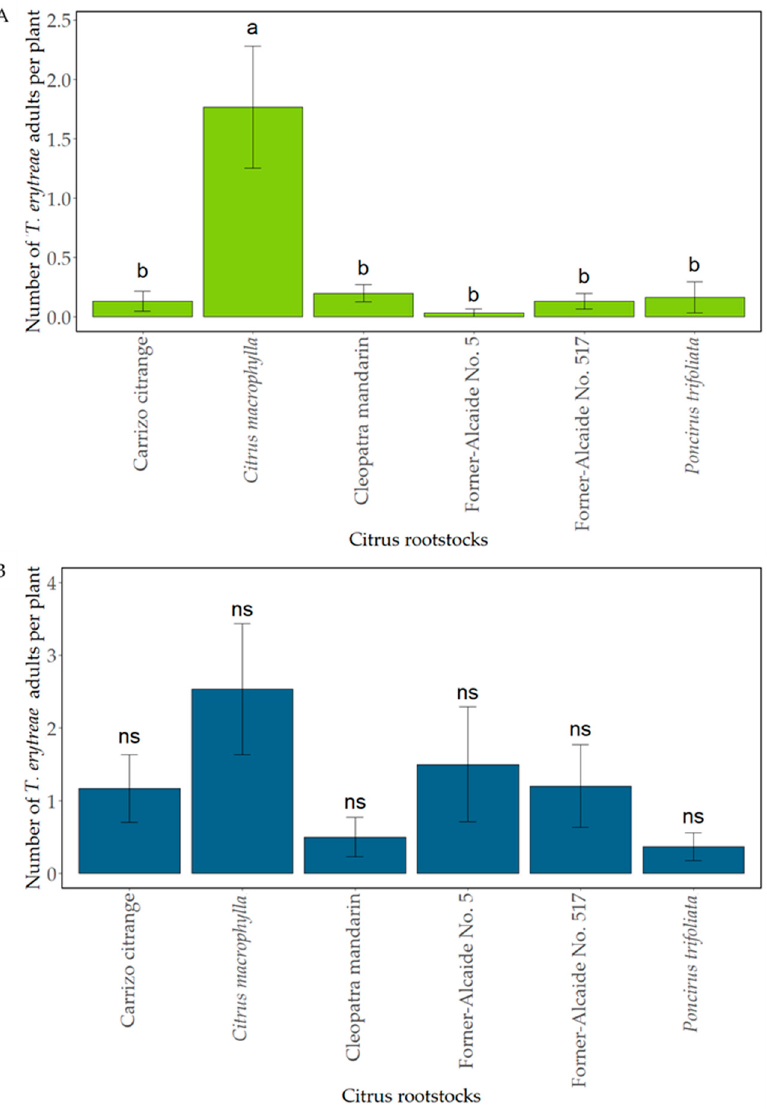
Figure 1. Mean of T. erytreae adults per plant ± standard error (SE) on the different non-grafted citrus rootstocks tested during the 21-day free-choice feeding experiment, performed under greenhouse conditions, in each year tested. ( A ) 2018. ( B ) 2019. Values in columns with different letters are significantly different among the rootstocks assayed per year by LSD-Fisher test ( p < 0.05). Poncirus trifoliata : Poncirus trifoliata (‘Flying Dragon’); ns: no significant differences.